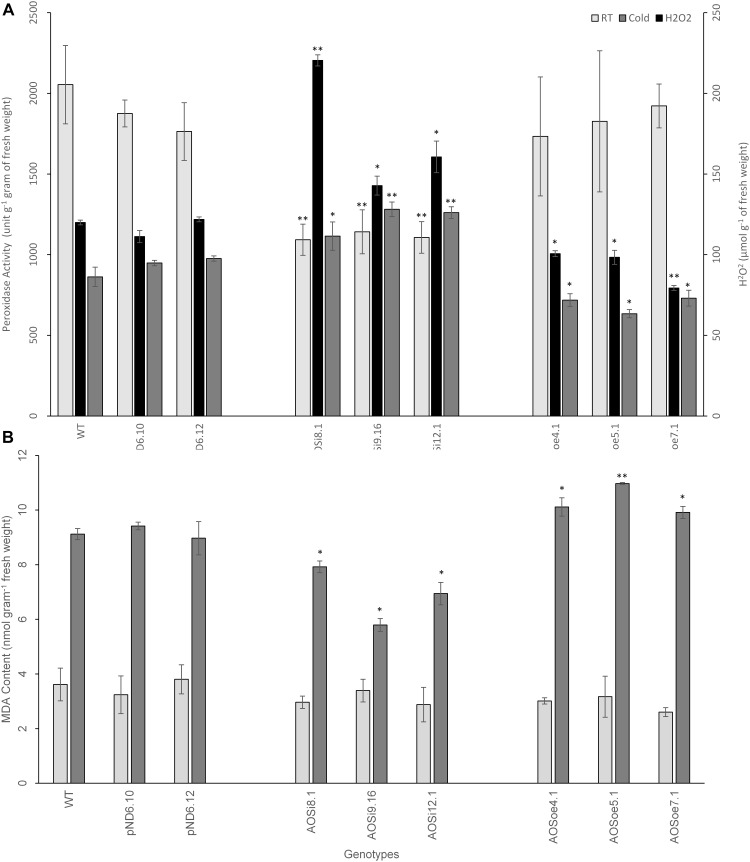
Spectrophotometric measurement from 8-week-old tissue culture-grown guayule control and transgenic lines for (A) H2O2 level and peroxidase activity and (B) lipid peroxidation as measured by MDA content in planta. Average values are from three biological replicates ± SD. ∗ and ∗∗ indicate significant difference at p > 0.05 and p > 0.005, respectively, in comparison to the WT. Data are representative of three independent experiments.